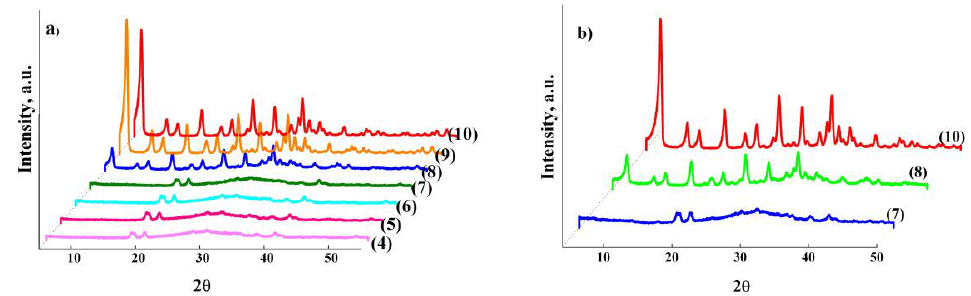
Figure 3. Wide-angle XRD patterns of Ti-containing samples at different aging times (Samples 4–10 from Scheme 1). ( a ) Zeolite Y with 1% TiO 2 ; ( b ) zeolite Y with 2% TiO 2 .